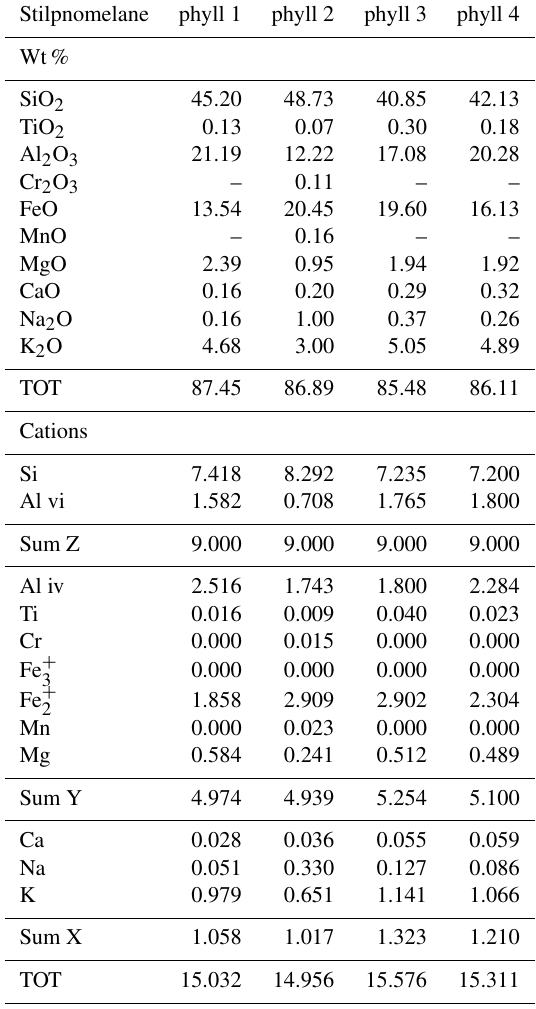
Table 2. Representative microprobe analyses of Stilpnomelane whose structural formulae were calculated assuming 24 oxygens and all Fe as divalent (Fe + 2